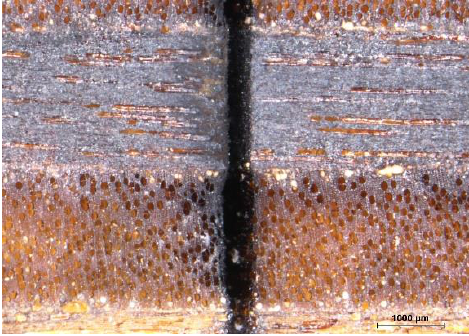
Figure 5. Microscopic image of the edge of a simple flexible specimen (poplar plywood) cut by laser. The dark zone corresponds to the transversal kerfing (magnification 22.5×).